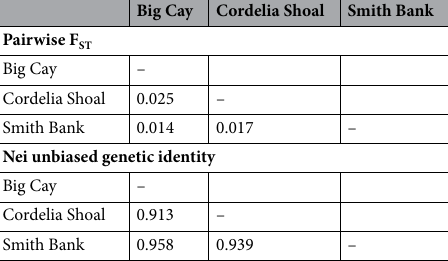
Table 3. Pairwise F ST and Nei unbiased genetic identity values of Acropora cervicornis colonies from three banks within the Cordelia Bank site of special importance to